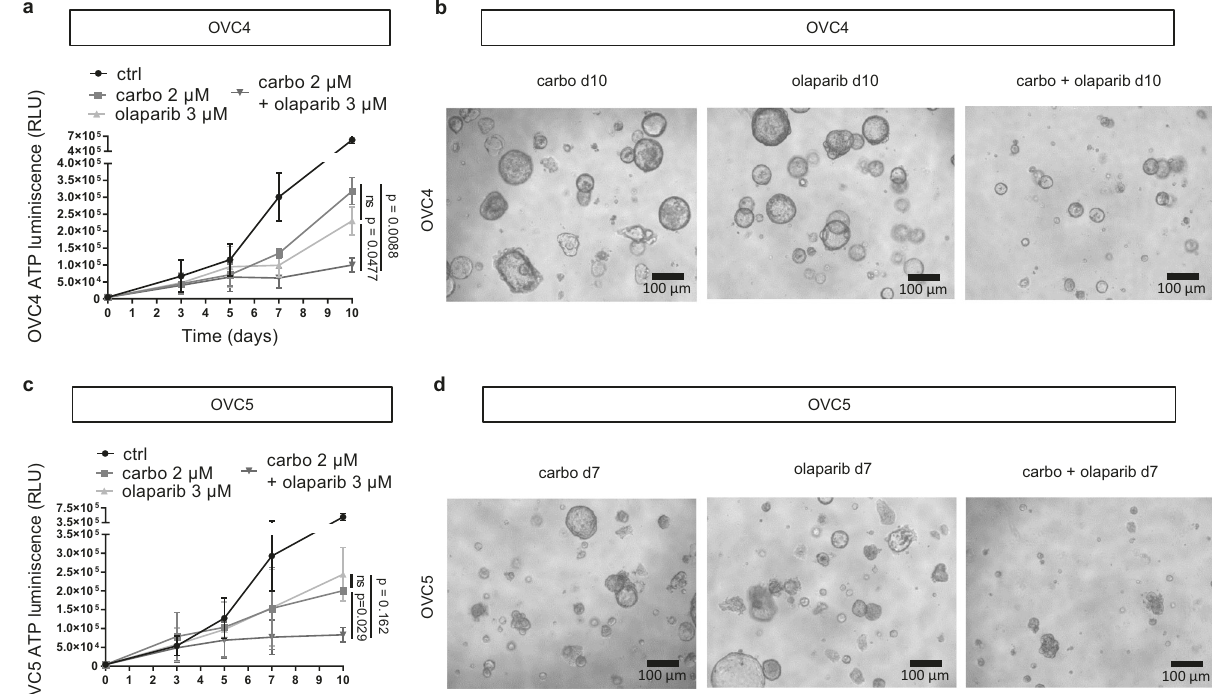
Fig. 7 | PARPi re-sensitizes resistant PDX-derived organoids to carboplatin. Growthof a OVC4organoidsundercarboplatinandolaparibsingleagenttreatment and its combination, determined by adenosine triphosphate (ATP) measurement, n =3 biological replicates (with six technical replicates each), data are represented as mean±SEM, unpaired two-tailed t -test performed at day 10, and b its repre- sentative pictures, scale bar is 100 µ m. Growth of c OVC5 organoids under